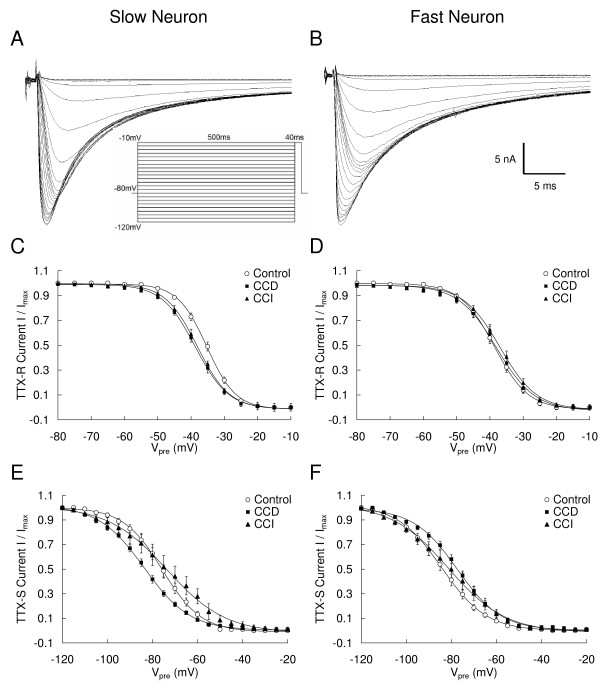
Alteration of the steady-state inactivation of TTX-R and TTX-S Na+ currents in slow and fast small DRG neurons after CCD and CCI treatment. A and B: Representative records of the inactivation current from a slow neuron (A) and a fast neuron (B) from a control DRG. The currents were recorded by using a double protocol with a 500 ms prepulse ranging from -120 mV to -10 mV (in 5 mV increments), followed by, with a 0.8 ms interpulse interval to -80 mV, a test pulse to -10 mV. The inter-pulse period was 10 s. The TTX-R inactivation currents were measured at the time of the peak current evoked following a -50 mV prepulse. The TTX-S inactivation currents were measured at the time of the peak of the maximum current evoked following a -120 mV prepulse. Each data set was normalized and fit with a Boltzman equation. The best fitted steady-state inactivation curves were showed in C-F.